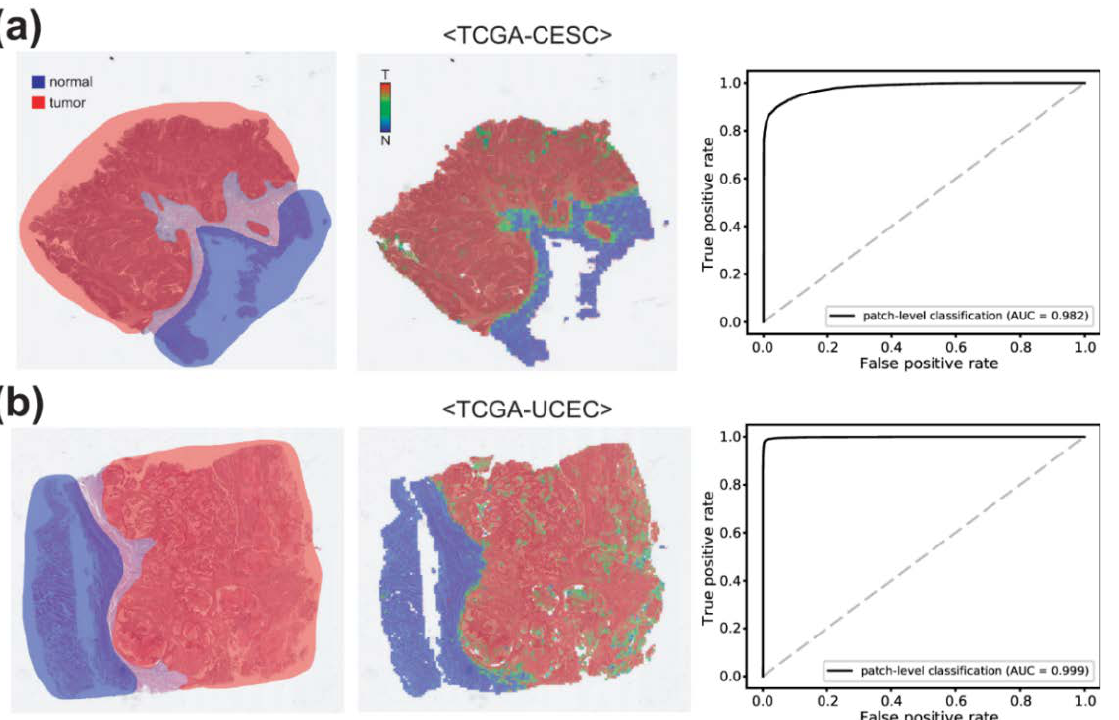
Figure 2. Normal/tumor classification results for ( a ) cervical and ( b ) endometrial cancers. Left panels: annotation made by pathologists. Middle panels: classification results of the normal/tumor classifiers. Right panels: Receiver operating characteristic curves for normal/tumor classification results. AUC: area under the curve.